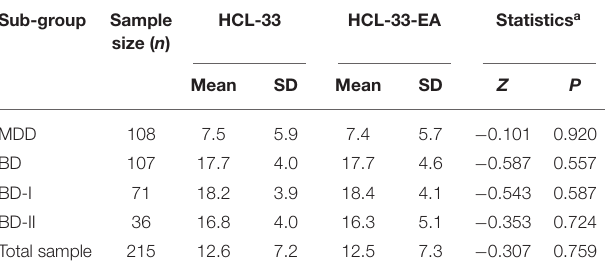
Frontiers in Psychiatry |